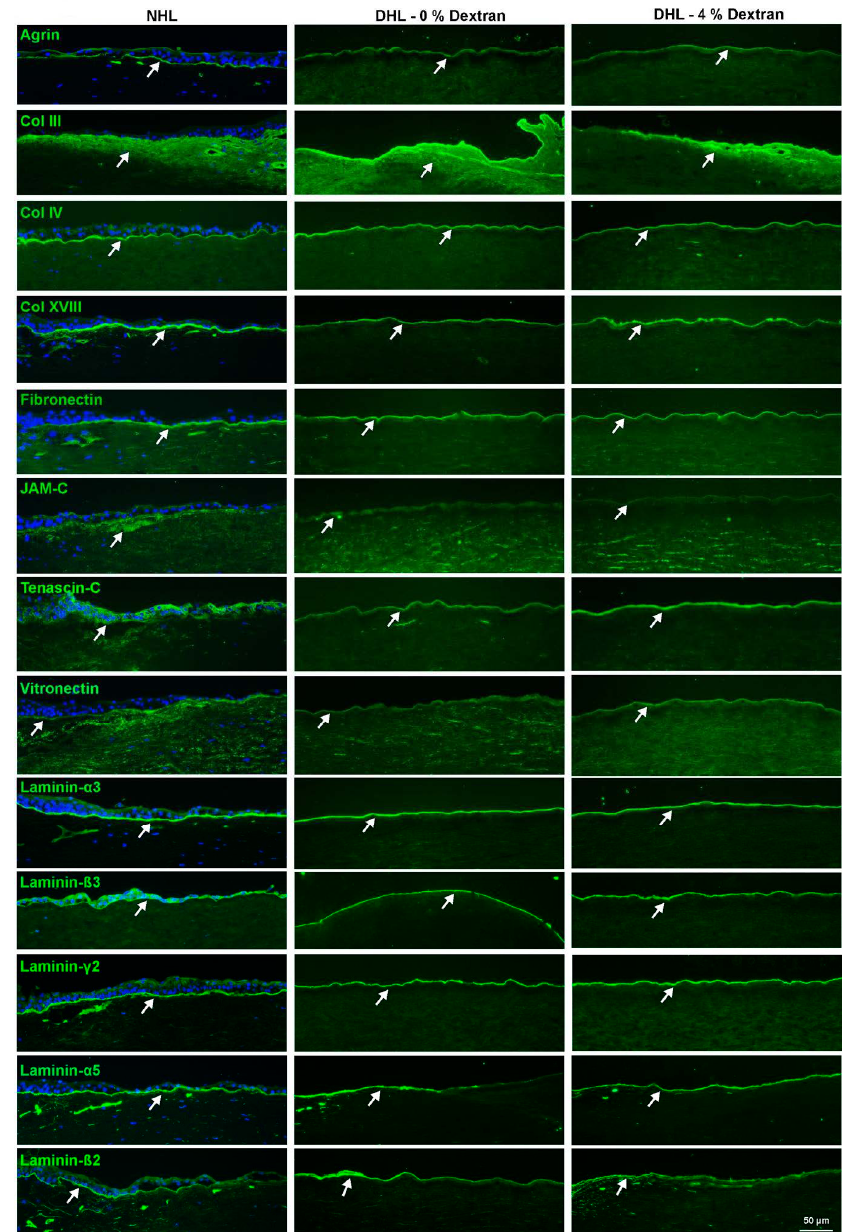
Figure 3. Extracellular matrix (ECM) composition of decellularized human limbus (DHL). Immunostaining analysis of various ECM and basement membrane (BM) molecules on the DHL (0 and 4% dextran) compared to the normal human limbus (NHL). Arrows indicate the expression of ECM and BM molecules. Nuclei counterstained with 4 ′ ,6-diamidino-2phenylindole (blue). Abbreviations: Col, Collagen; JAM-C, junctional adhesion molecule C.